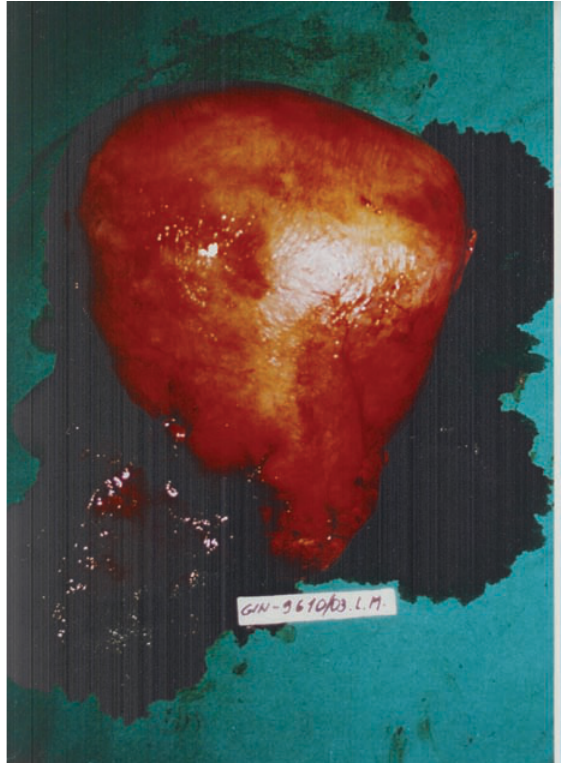
Figure 1. Cervicoisthmic posterior complete uterine